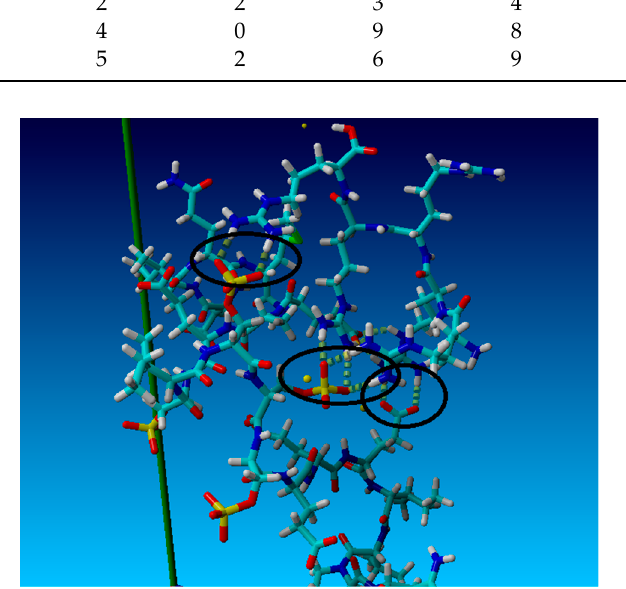
Figure 9. Snapshot from the molecular dynamics simulations illustrating formation of bi-dentate hydrogen bonds between guanidine group of polyarginine and phosphate or carboxyl group of casein. Table 4. The number of anionic residues, charge, the average number of hydrogen bonds formed by casein fragment with arginine and lysine oligomer and the difference of the hydrogen bonding energy that resulted from the molecular dynamics simulations.